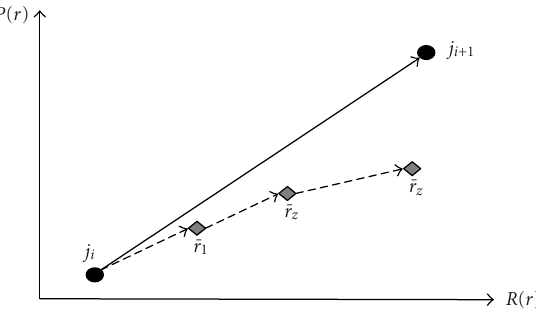
Figure 6: The parameters ¯ r 1 , ... , ¯ r Z between j i and j i +1 are not part of convex hull points and have decreasing